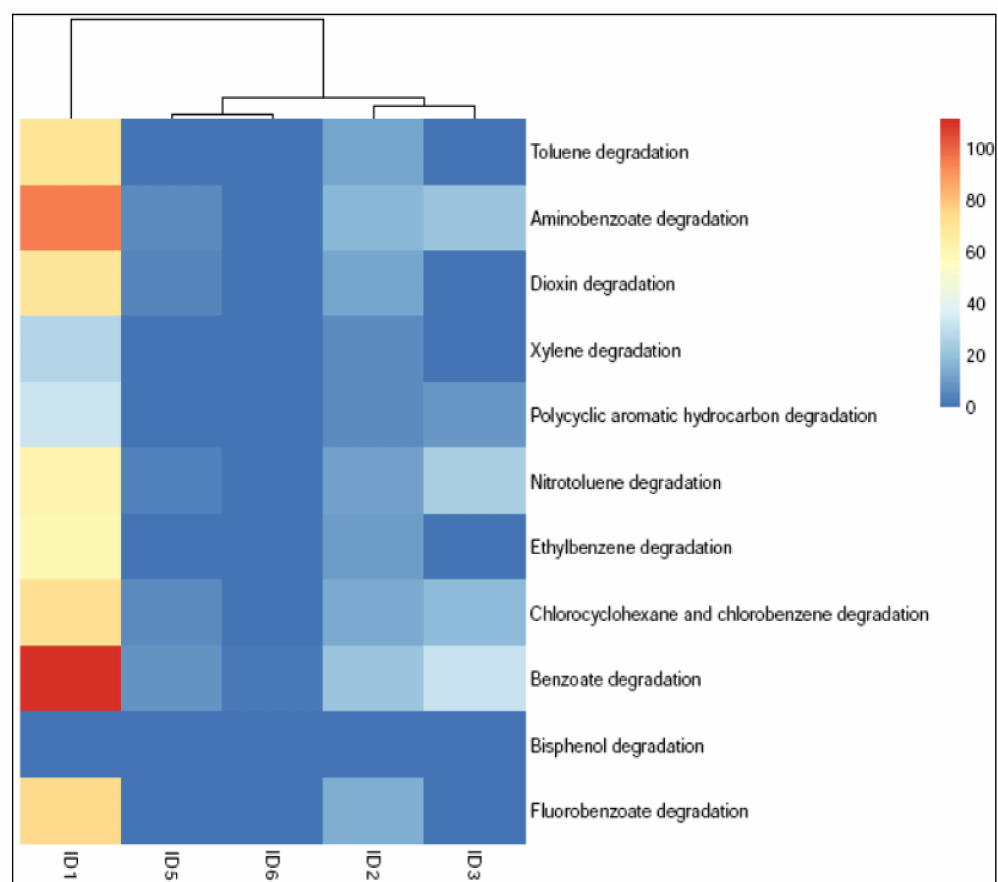
Figure 4. Predicted functional degradative genes in bacterial communities identified across informal dump site soil